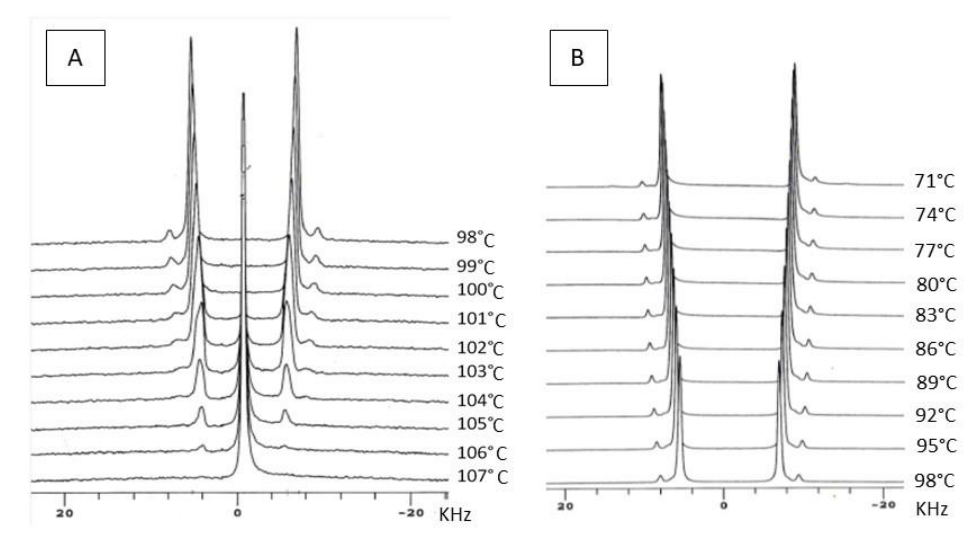
Figure 3. Stackplot of 1 H-decoupled 2 H NMR static spectra of the 10DClPBBC-d 4 sample, recorded by cooling the sample from the isotropic phase: ( A ) from T = 107 °C to 98 °C (every 1 °C) and ( B ) from T = 98 °C to 71 °C (every 3 °C).